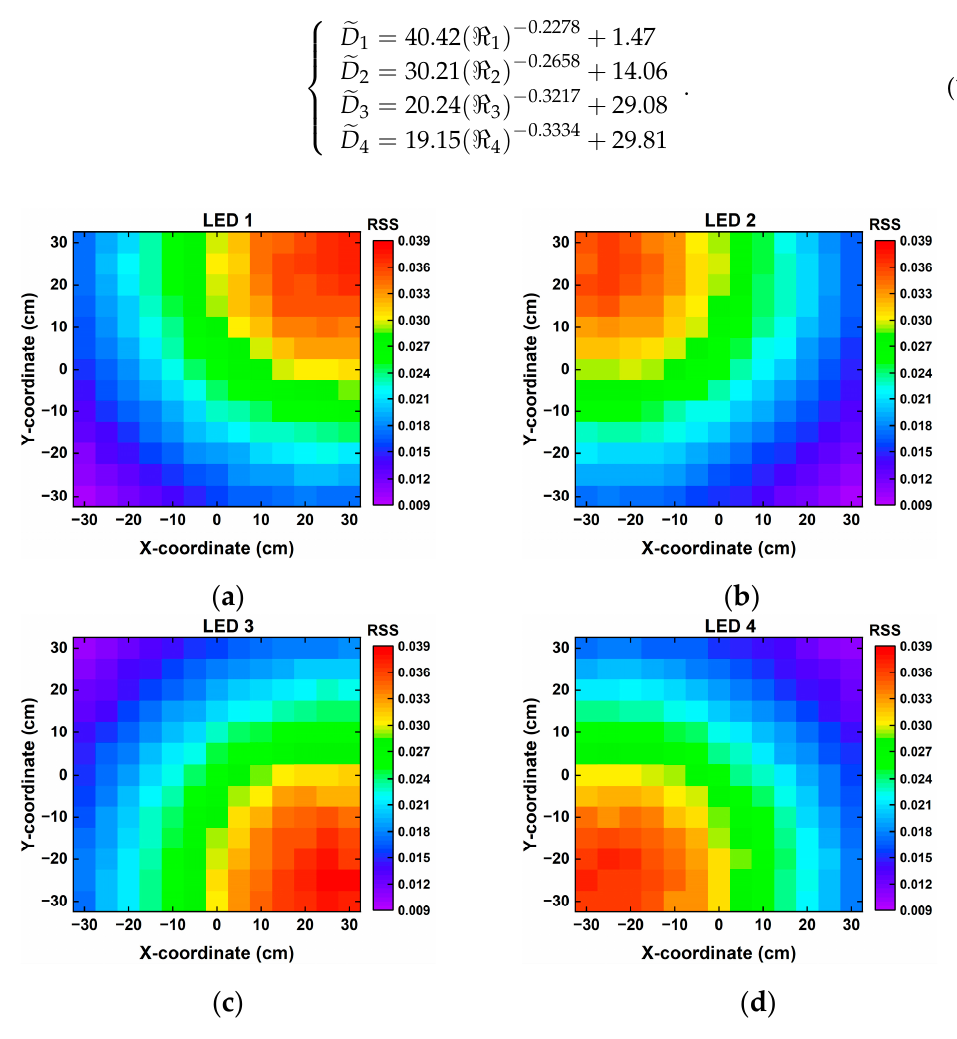
Figure 11. The RSS distributions of ( a ) LED 1, ( b ) LED 2, ( c ) LED 3, and ( d ) LED 4.